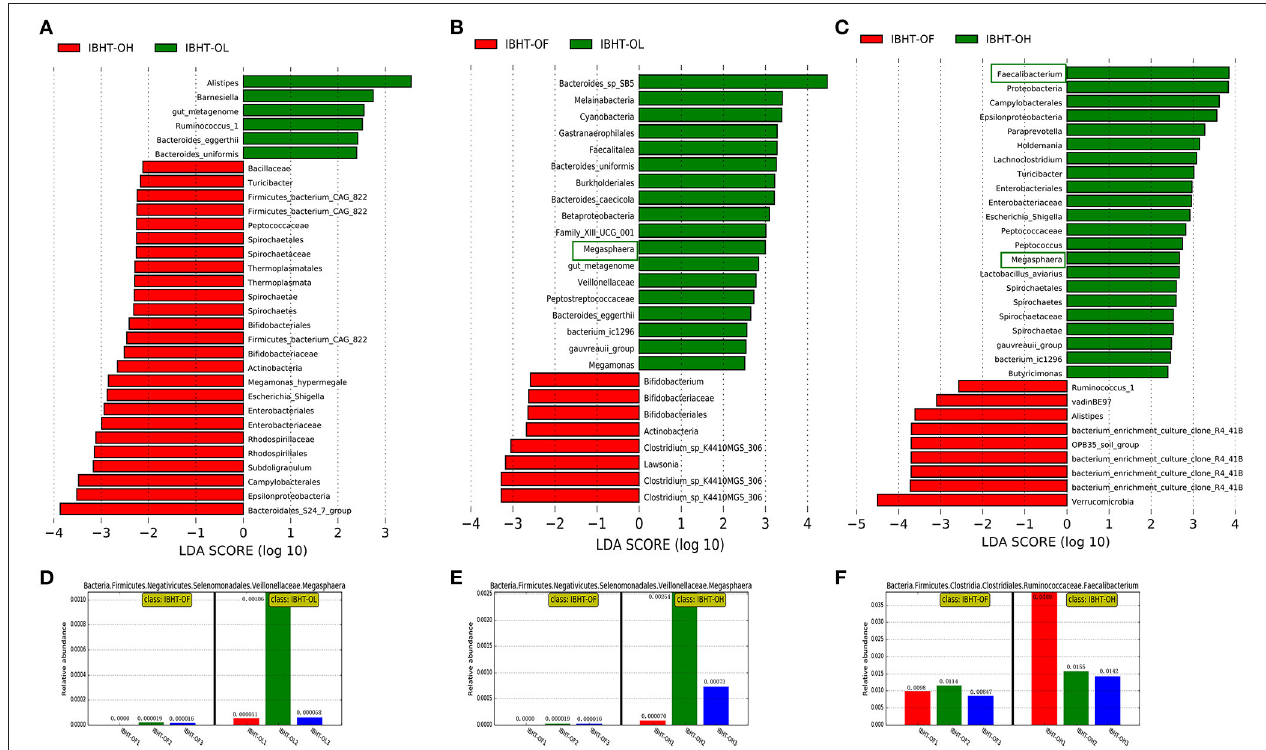
FIGURE 5 | LDA (linear discriminant analysis) among groups of ISA Brown hens–20 weeks (IBHT) and abundance histograms of the dominant bacteria. (A) IBHT-OL vs. IBHT-OH. (B) IBHT-OL vs. IBHT-OF. (C) IBHT-OH vs. IBHT-OF. (D,E) The abundance histogram of dominant butyrate-producing genus Megasphaera in the OL group (green frame, B ) and OH group (green frame, C ) compared to the OF group. (F) The abundance histogram of dominant butyrate-producing genus Faecalibacterium (green frame, C ) in the OH group compared to the OF